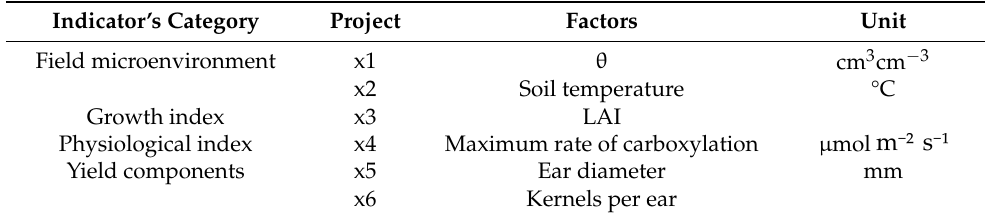
Table 5. Index system of yield influencing factors.